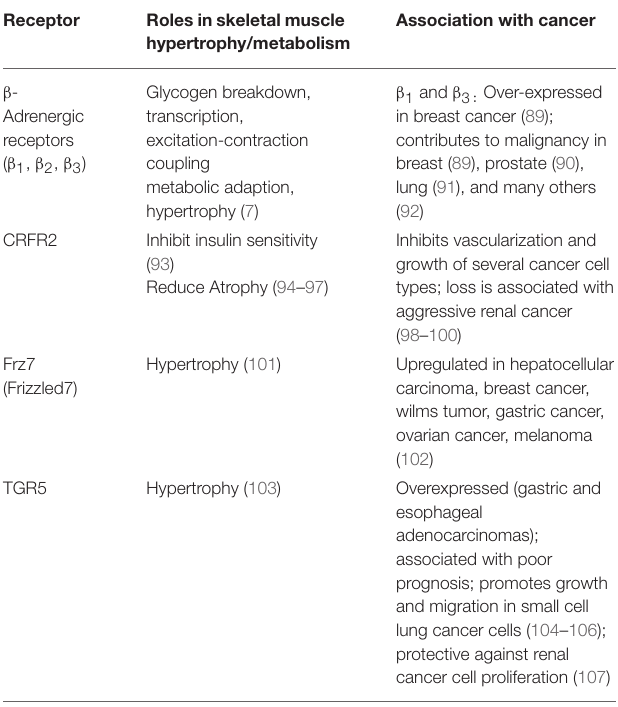
Table indicates muscle phenotypes induced by the indicated GPCRs and the association of the GPCRs with cancer. that pharmacologic activation of Gs-coupled GPCRs in skeletal muscle or pharmacologic blockade of CRTC inhibitory